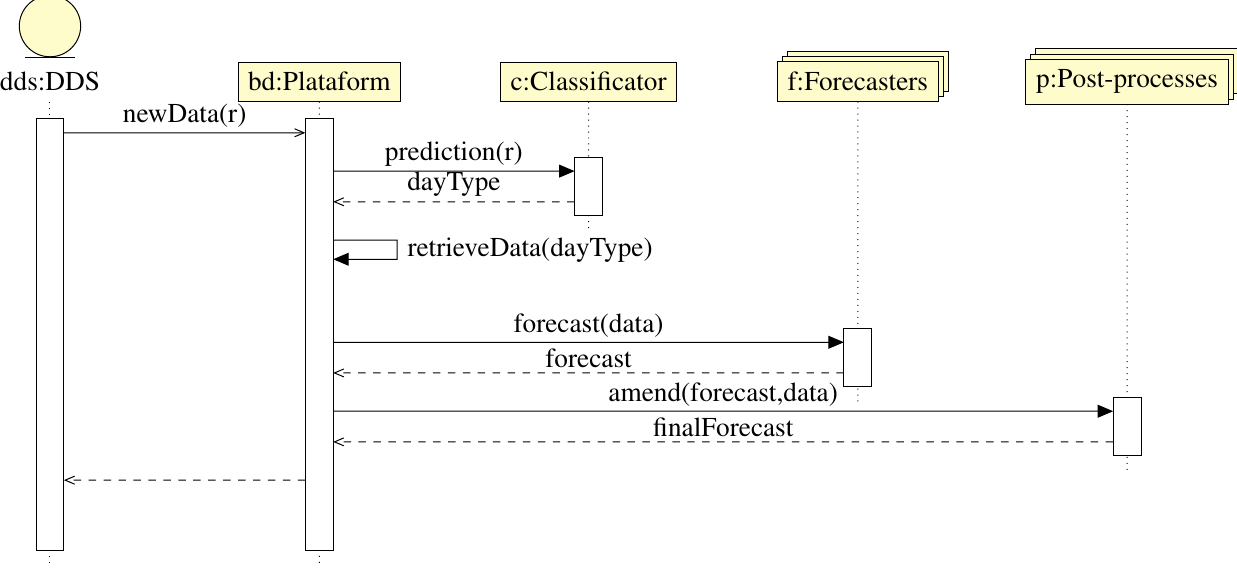
Figure 1. Sequence diagram of the proposed